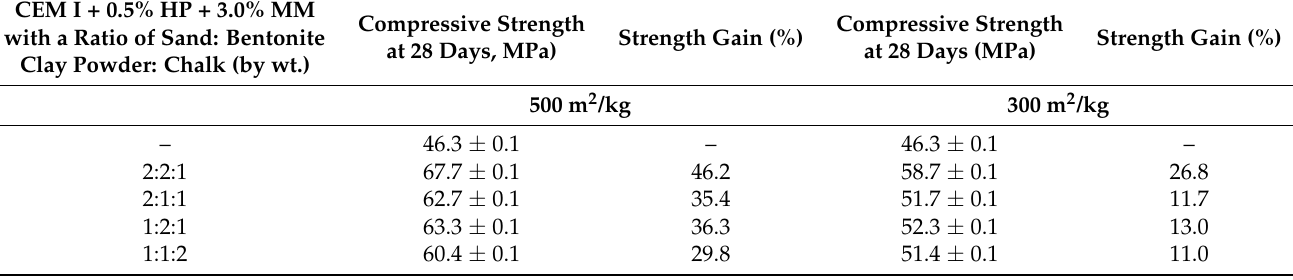
Table 7. Compressive strength of the composite